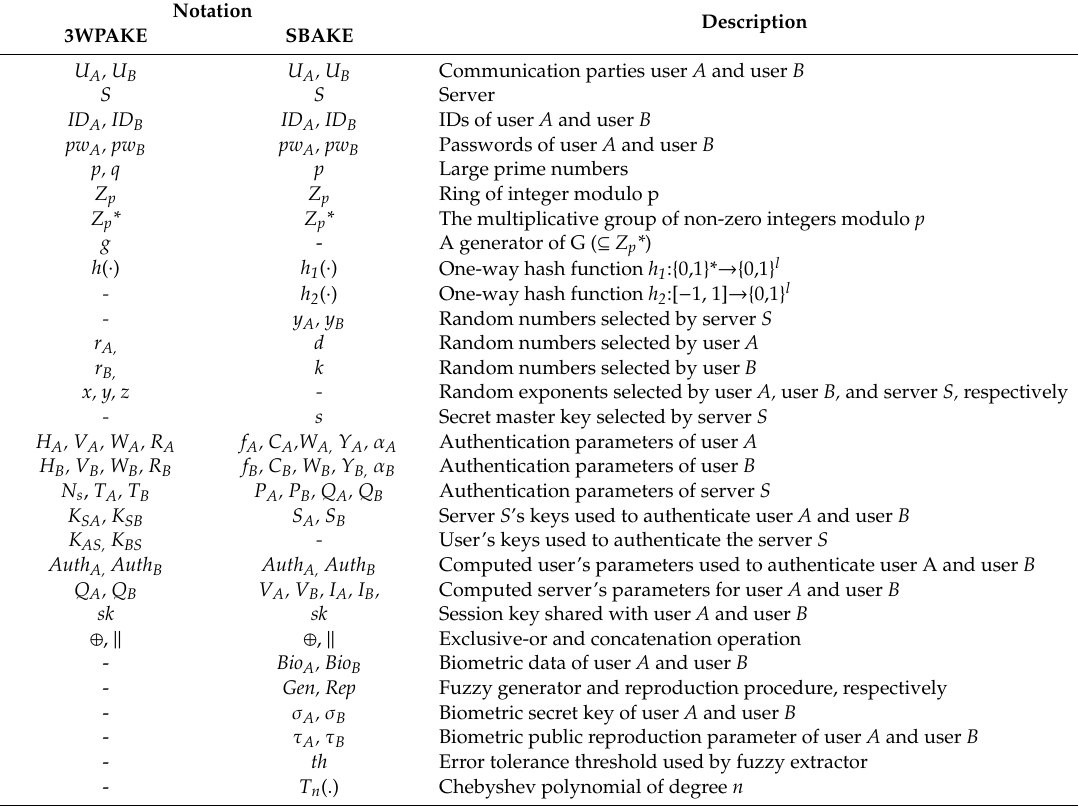
Table 1. Notations used in this paper and